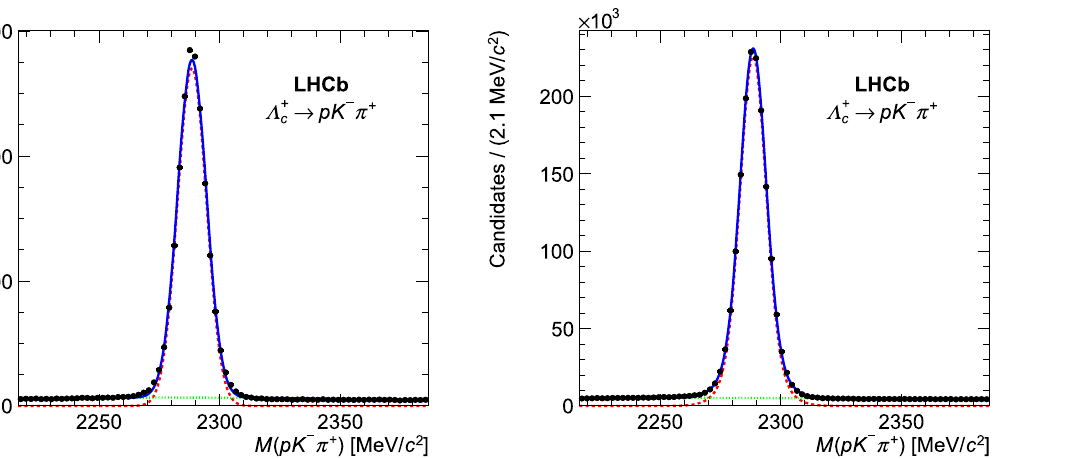
sum of two Gaussian functions with the same mean and different widths (red dashed line) and a second-order Chebyshev polynomial function (green dotted line) describing the signal and background components